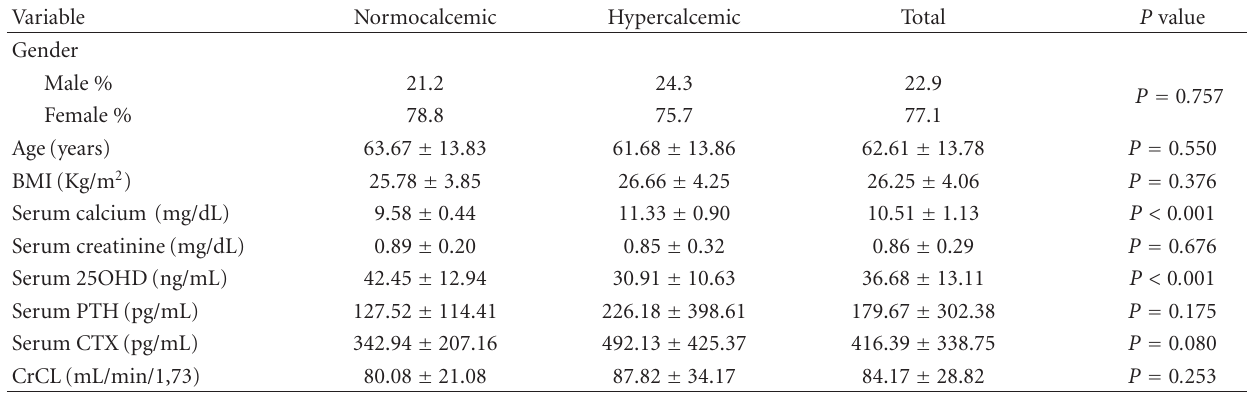
Table 1: Baseline characteristics of study